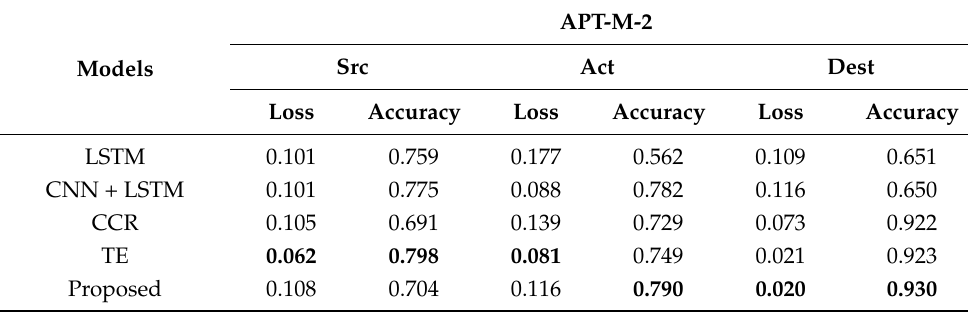
Table 6. Performance based on APT-M-2 and neighborhood